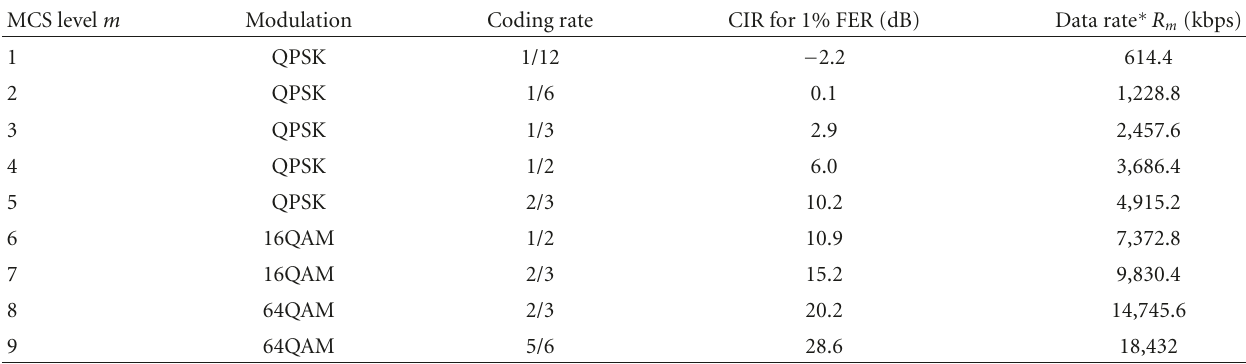
Table 2: Transmission modes for AMC.